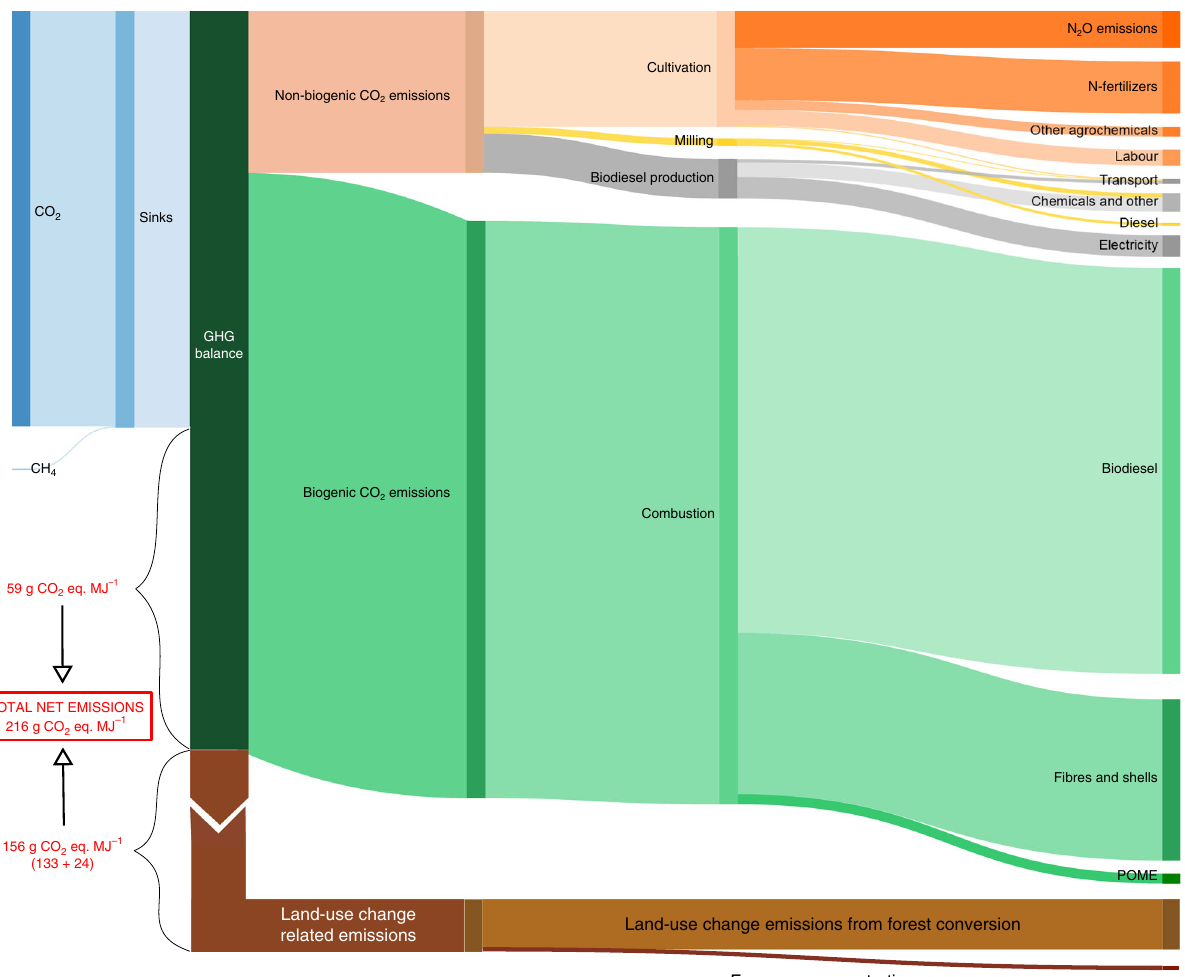
Fig. 3 Detailed life cycle analysis for business-as-usual scenario. Detailed life cycle analysis of palm-oil biodiesel for the business-as-usual scenario in the fi rst-rotation cycle. Greenhouse gas (GHG) budget over the entire plantation life cycle of 25 years. Each box represents a GHG fl ux and box sizes are proportional to fl ux magnitude. The GHG balance box (dark green) comprises the GHG sinks to its left and the emissions to its right. The difference between sinks and emissions, i.e., the net GHG emissions, are indicated by brackets. Sinks (left side, blue) by the ecosystem include carbon dioxide (CO 2 ) and methane (CH 4 ) fl uxes. Emissions (right side) are separated into the phase along the cycle, in which they occur, i.e., palm oil cultivation (orange), milling (yellow), biodiesel production (grey), biogenic emissions occurring during the use of the different products obtained along the system (green), land- use change emissions from forest conversion (light brown) and foregone sequestration (dark brown). All fl uxes are expressed in gCO 2 -eq. MJ − 1 . Due to their large magnitude, box sizes for land-use change-related emissions are not proportional to the magnitude of the fl uxes. See Supplementary Table 3 for further details on the business-as-usual